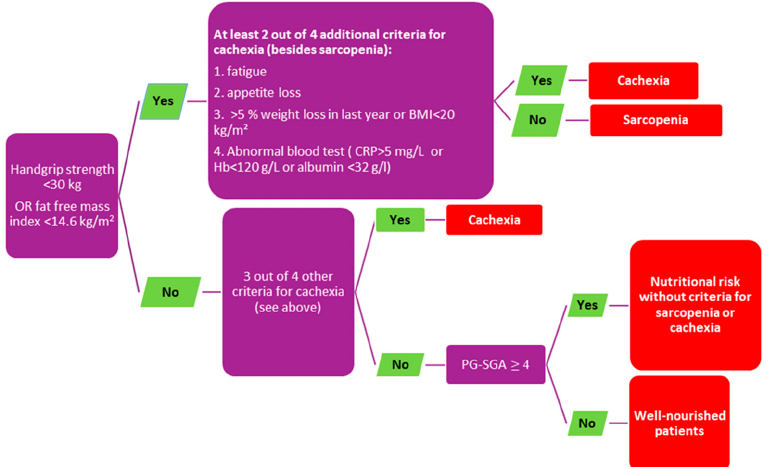
Figure 1. Algorithm for allocation in nutritional status category. (BMI body mass index, CRP C-reactive protein, Hb hemoglobin, PG-SGA patient generated subjective global assessment).